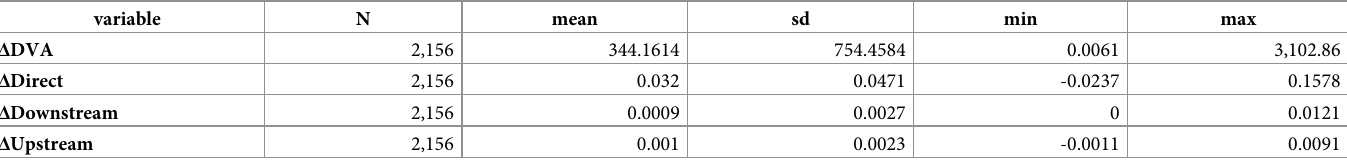
Table 1. Descriptive statistics.